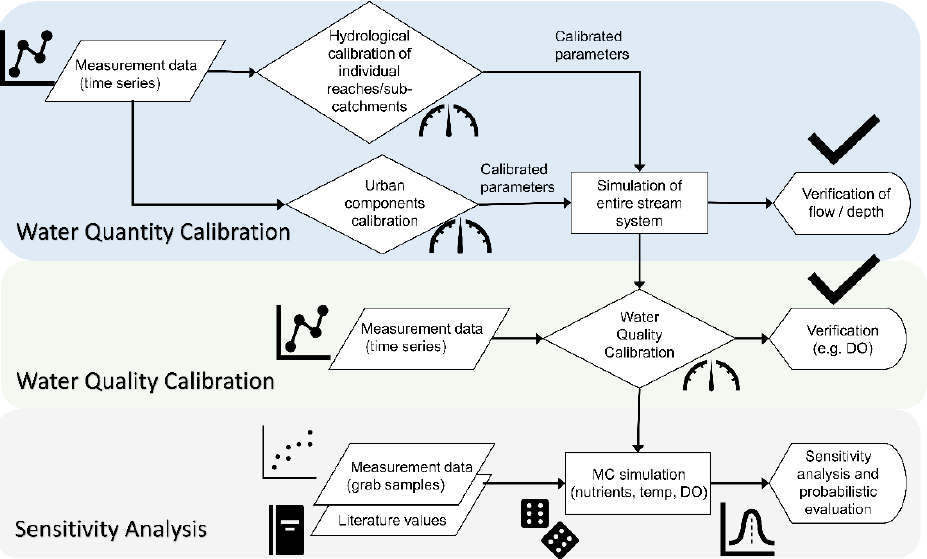
Figure 3. Flowchart depicting the data-driven application of the model. Calibration and verification for the water quantity module is carried out first, followed by the water quality module, where time-series data are available. Sensitivity analyses can then be conducted using the calibrated model to determine key water quantity (see Figure S17) and water quality (Figure S18) variables. These can be used further in a probabilistic application of the model, where the Monte Carlo (MC) method is applied. All values for these simulations have been derived either from the literature or site-specific (grab sample) data (see Tables S5 and S6 for values and